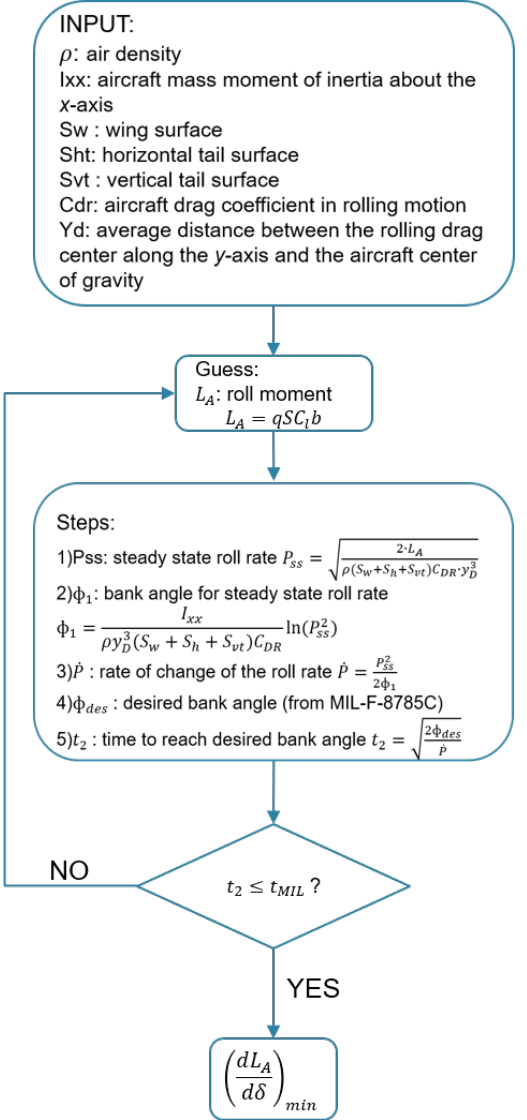
Figure 6. Scheme for minimum roll moment derivative, reversing aileron design from